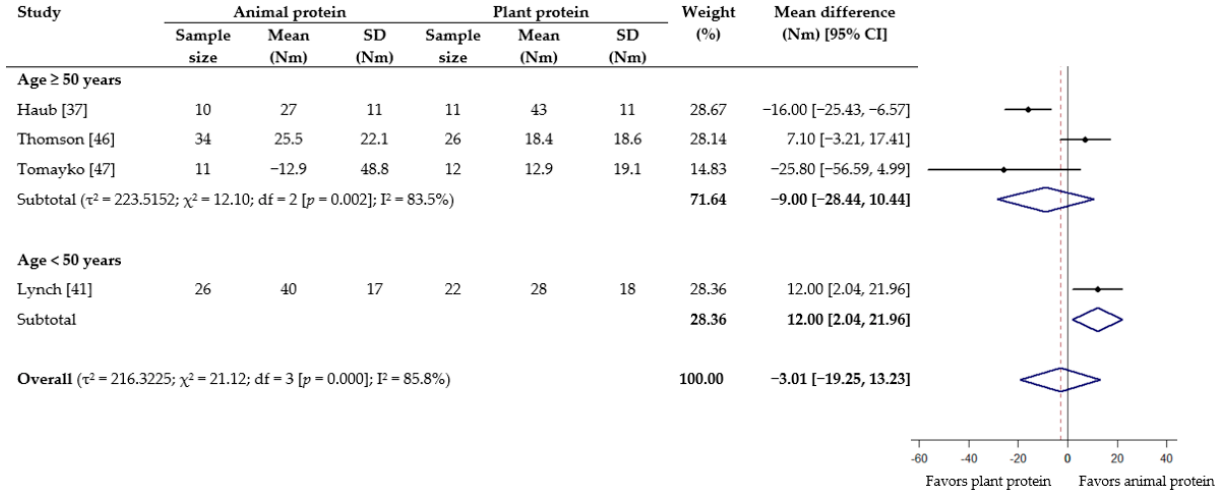
Figure 5. Effect of consuming animal protein compared to plant protein on changes in peak torque of leg/knee extension (Nm) based on age group. Data expressed as weighted mean differences with 95% CIs, using a random ‐ effects model. Nm: Newton meter.